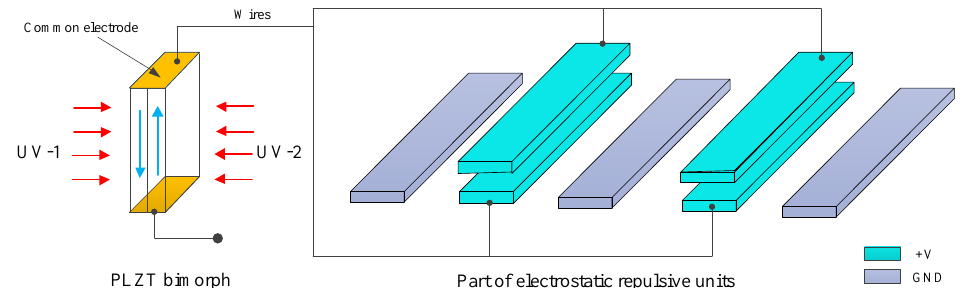
Figure 3. Working principle of a photovoltaic – electrostatic repulsive actuator.